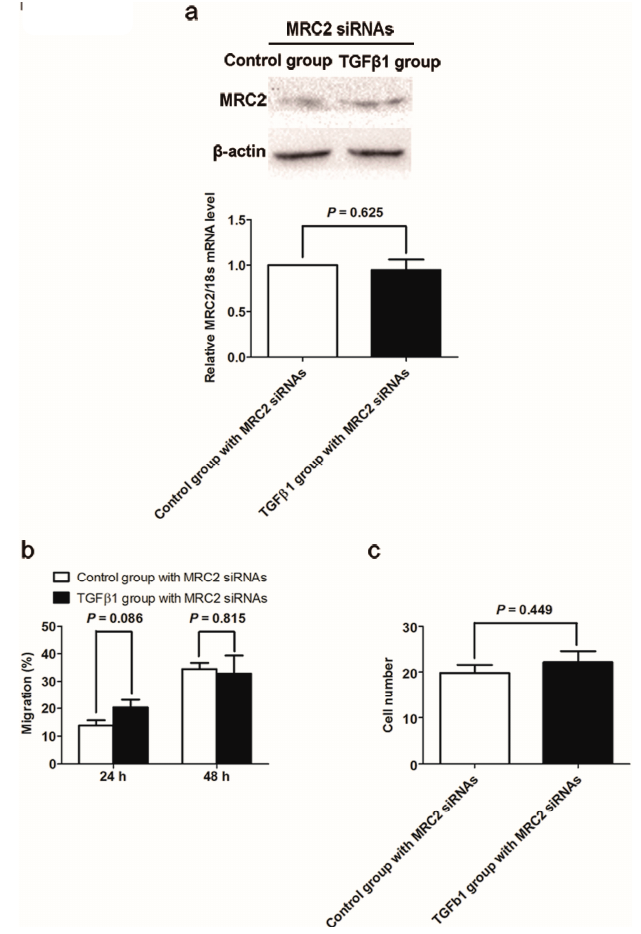
Figure 4. ( a ) As assessed by both western immunoblotting and qRT-PCR assays, TGF β 1 treatment leaded to up-regulation of MRC2 in Huh7 cells significantly; ( b ) TGF β 1 treatment promoted migration of Huh7 cells apparently; and ( c ) Invasion capacity of Huh7 cells was significantly enhanced by TGF β 1 treatment ( p =